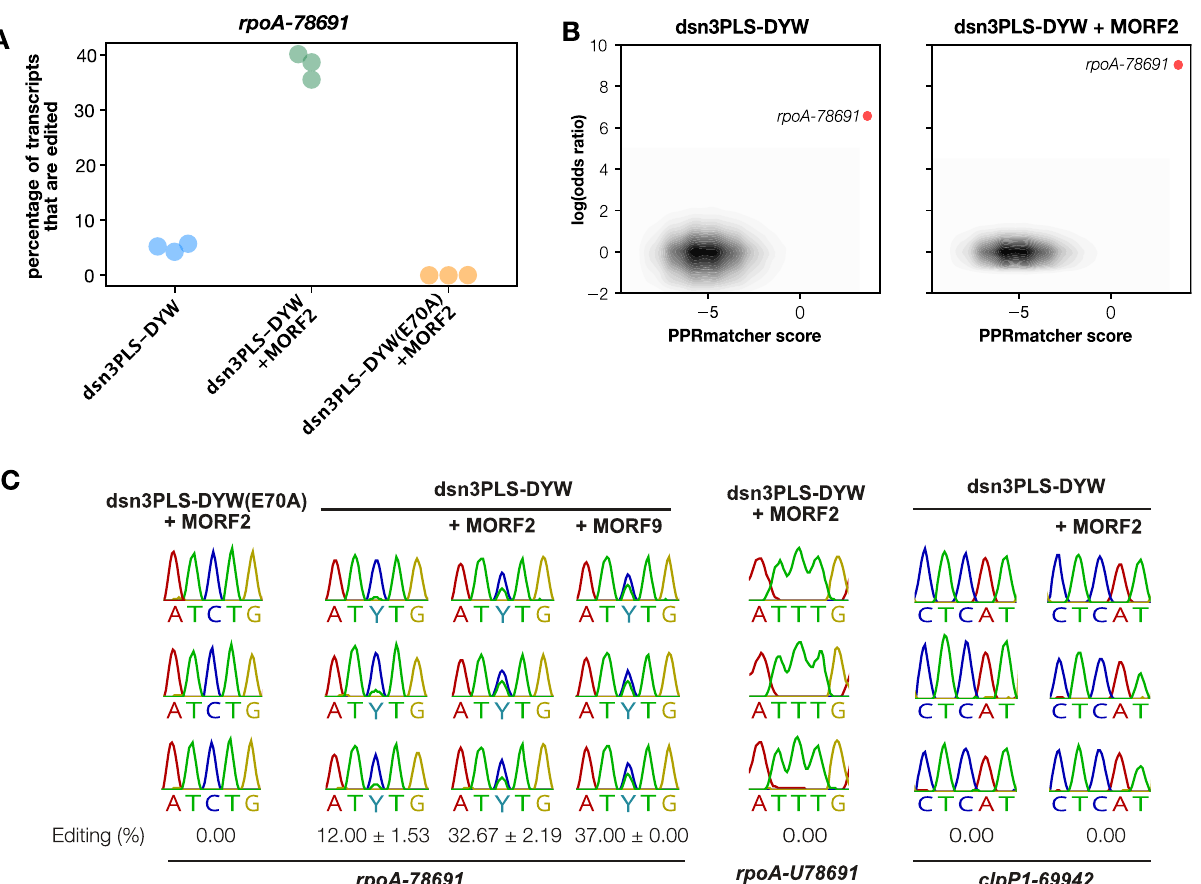
Fig. 5 RNA editing in bacteria. A RNA editing quanti fi ed by RNAseq at the intended target site in three independent samples of bacteria expressing dsn3PLS-DYW, dsn3PLS-DYW together with MORF2 or dsn3PLS-DYW(E70A), together with MORF2. B Potential editing sites plotted by their predicted binding to dsn3PLS-DYW ( x -axis) against the ratio of editing activity compared to the negative control (dsn3PLS-DYW(E70A) together with MORF2), expressed as the log of the odds ratio. Predicted binding scores were calculated with PPRmatcher (https://github.com/ian-small/PPRmatcher). The only signi fi cant site where the log(odds ratio) exceeds 2 is the intended target site, rpoA-78691 , highlighted in red. The ~492,000 sites below this threshold are indicated by the density contours (grey-black). C Additional tests of editing in E. coli . From left to right: dsn3PLS-DYW(E70A) + MORF2 as a negative control; MORF2 and MORF9 enhance editing by dsn3PLS-DYW by similar amounts; a U at the rpoA-78691 editing position is not detectably